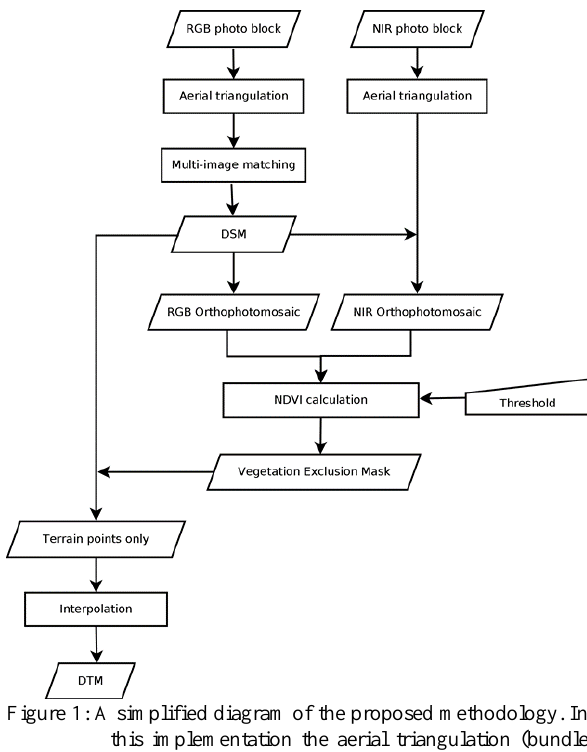
Figure 1: A simplified diagram of the proposed methodology. In this implementation the aerial triangulation (bundle adjustment) was performed in a joined block of NIR and colour